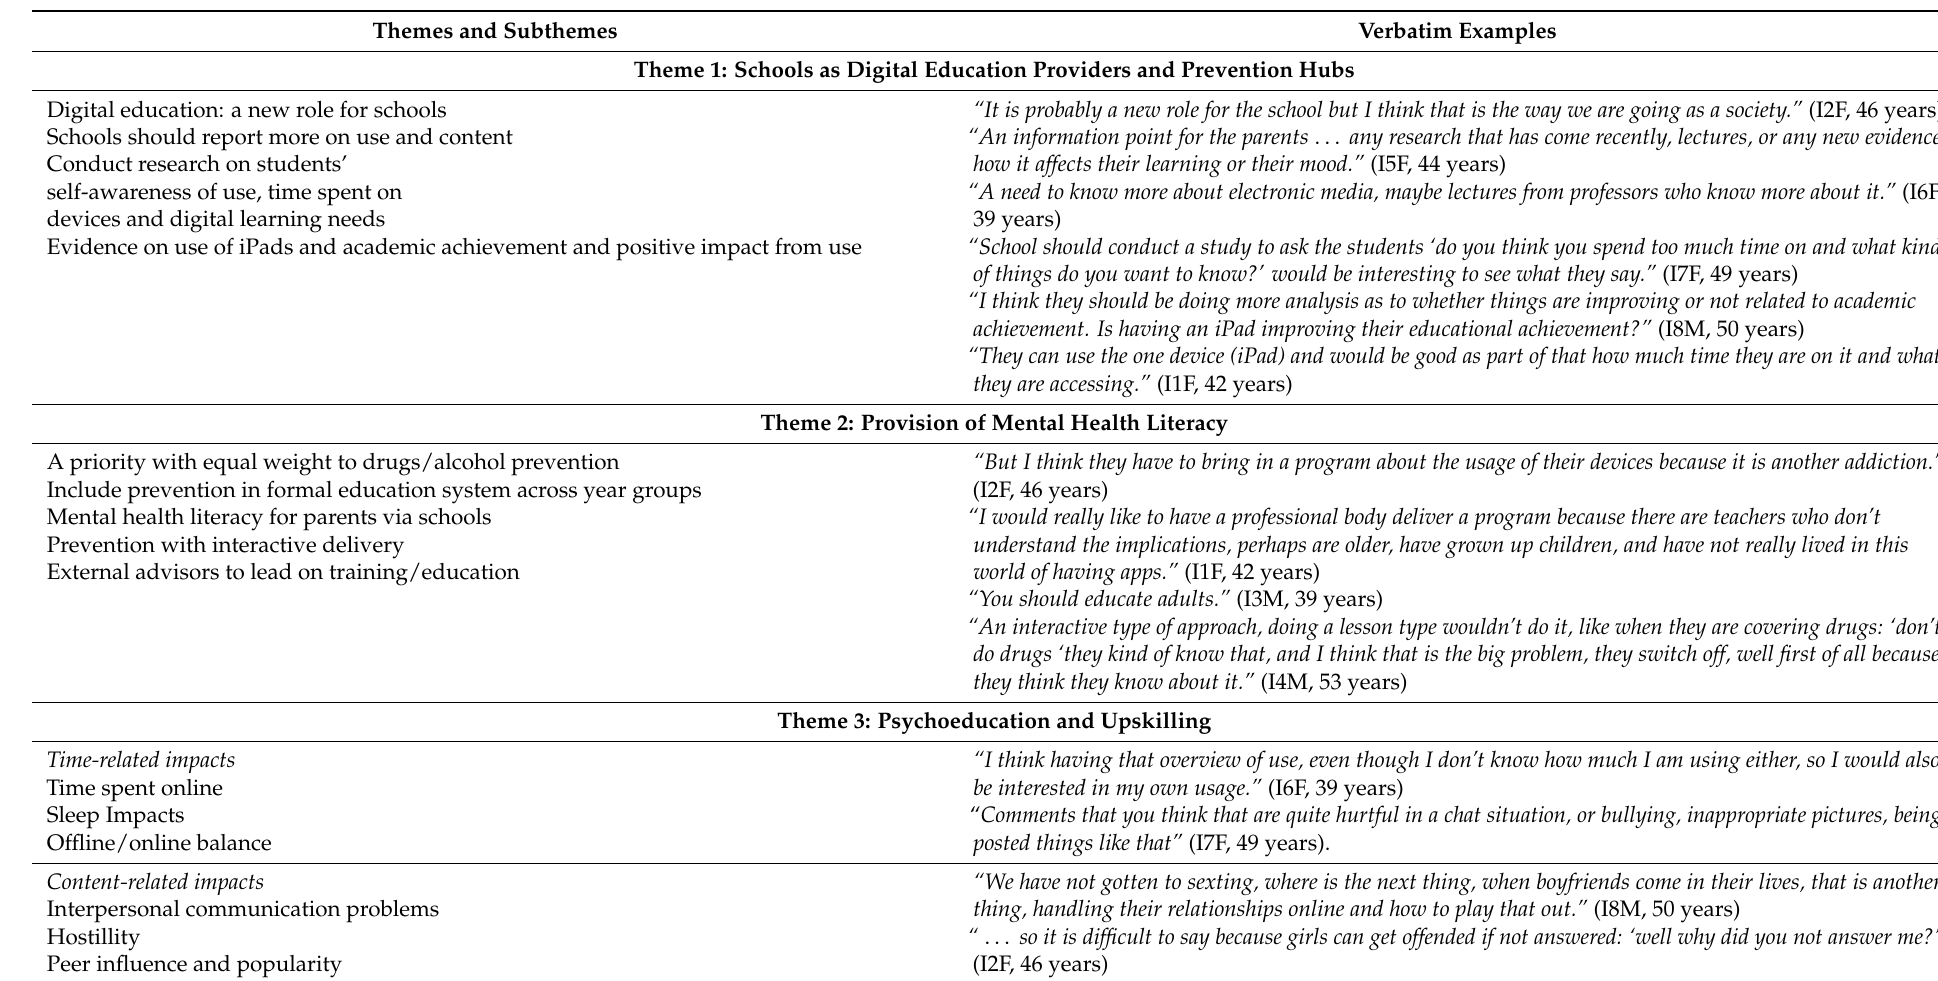
Table 1. Parental recommendations for prevention needs relating to gaming and social media